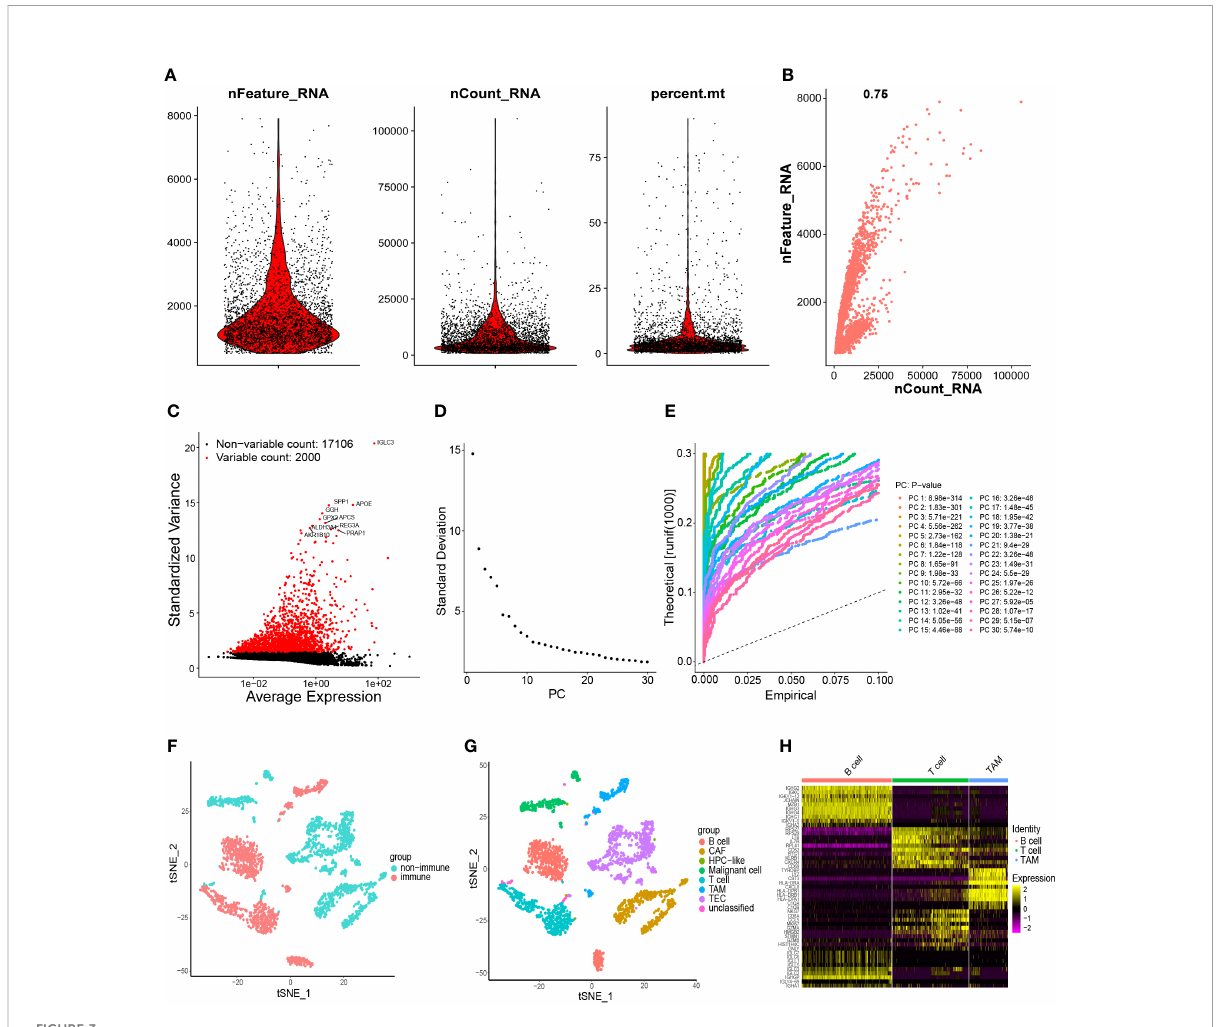
FIGURE 3 Processing of scRNA-seq data and acquisition of TAM marker genes. (A) Quality control of scRNA-seq data of samples of HCC cells. (B) The number of genes detected was positively associated with the depth of sequencing. (C) Scatter plots showing the top-2000 differentially expressed genes. (D, E) Principal component analysis was employed to classify the cells, and the top-30 PCs are displayed. (F) Initially, cells were annotated as “ immune cells ” and “ non-immune cells ” by the t-SNE algorithm. (G) Further detailed annotation of cells. (H) Heatmap demonstrated the marker genes with differential expression in immune cells. scRNA-seq, single-cell RNA-seq; TAM, tumor-associated macrophage; HCC, hepatocellular carcinoma; PCs, principal components; t-SNE, t-distributed stochastic neighbor